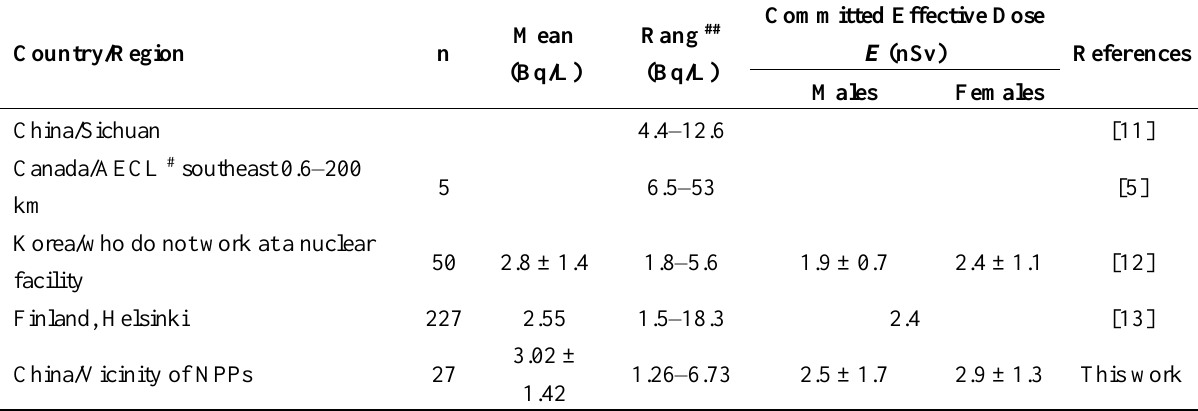
Table 3 ． Tritium concentration in urine and committed effective doses for the exposed workers and the general public for tritium according to reported in the